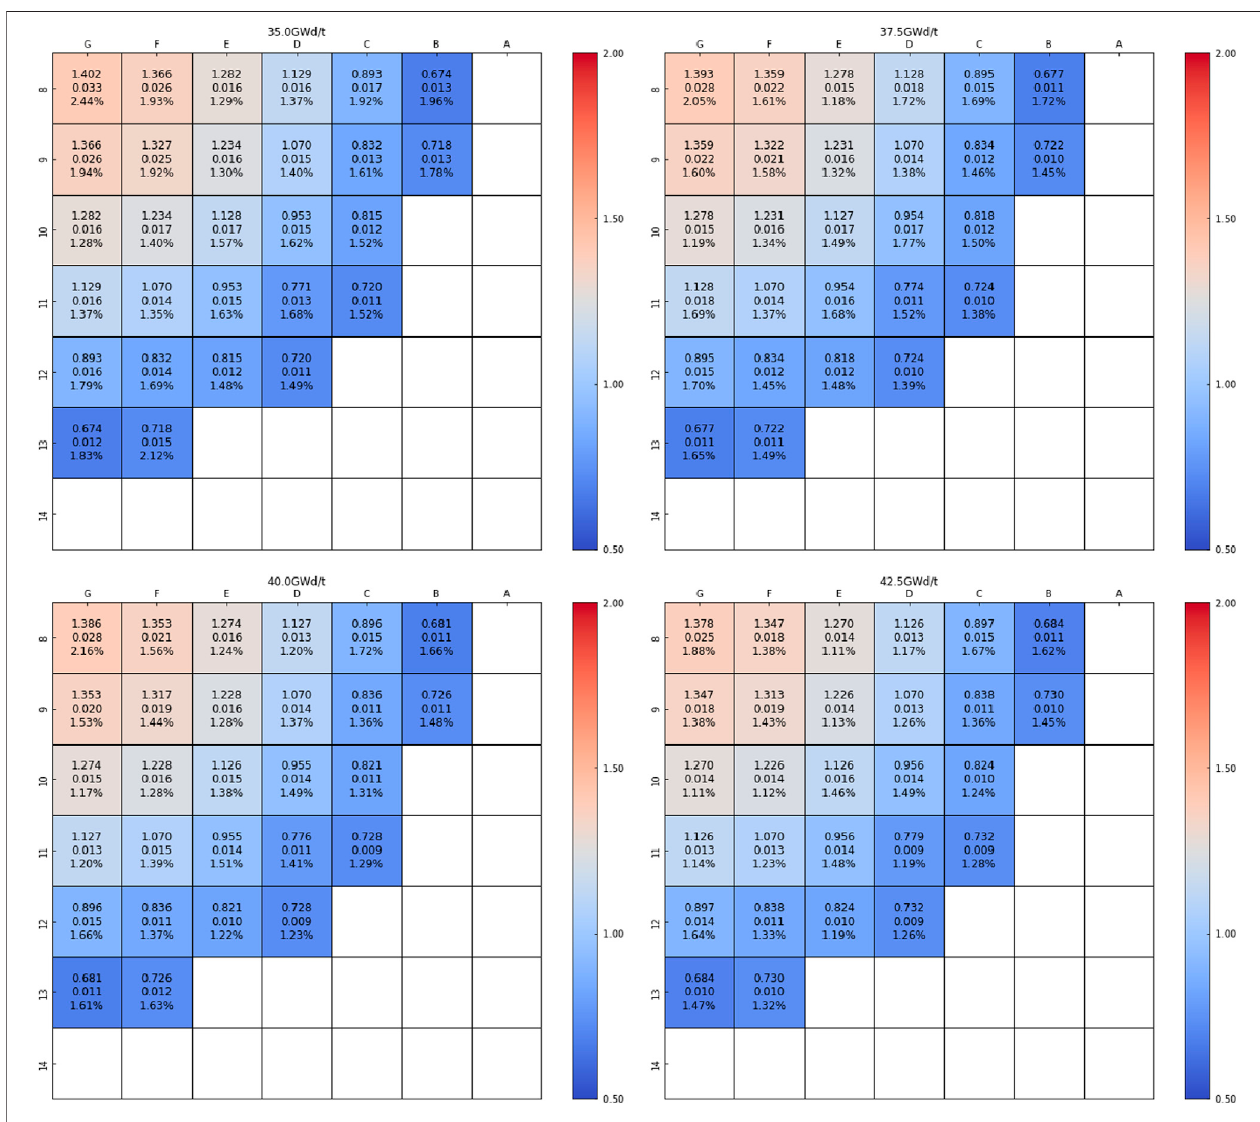
FIGURE 10 | Power distribution prediction result of the MOC. First line: assembly average power. Second line: mean absolute error. Third line: average value of absolute relative error.